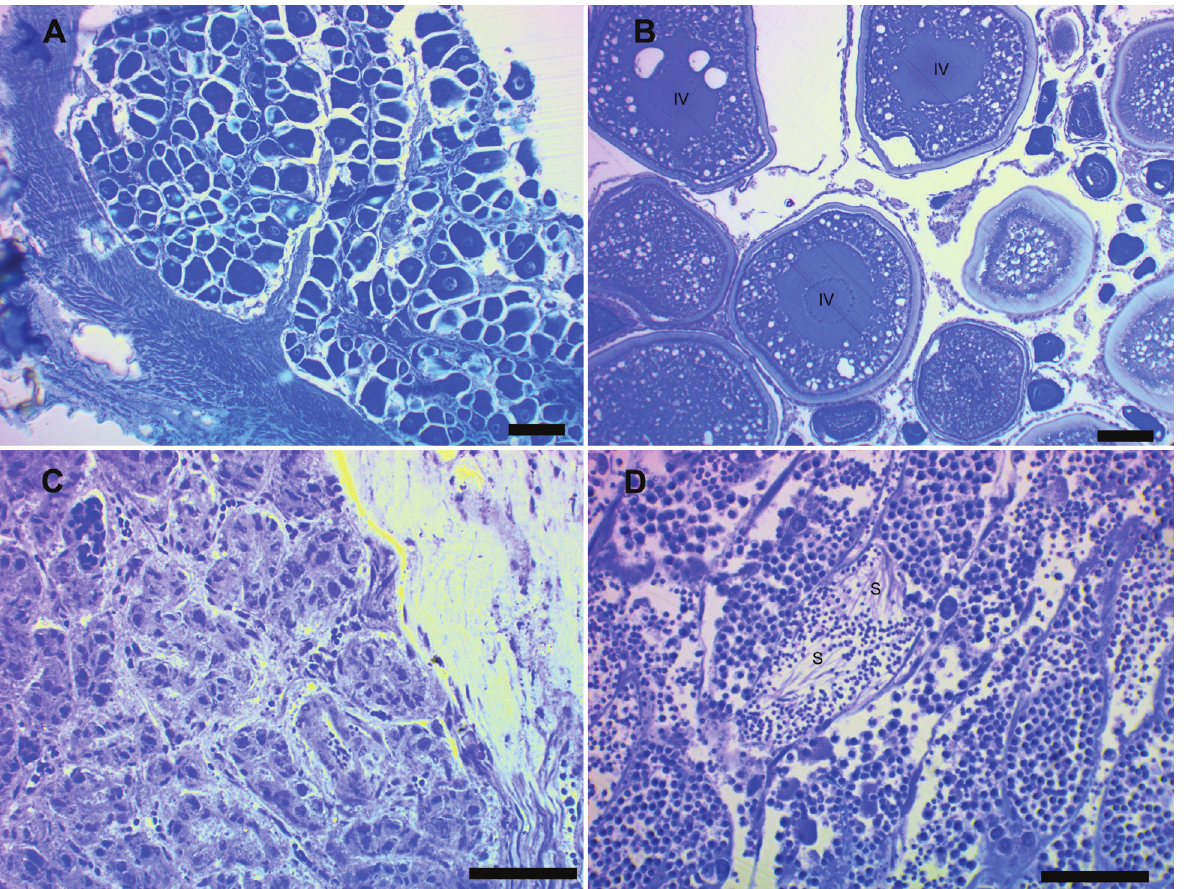
Figure 2. Histological sections of gonads of Lutjanus gibbus from Fiji. ( A ) Ovary of immature female (21.6 cm L primary-growth oocytes; ( B ) ovary of mature female (27.3 cm L (IV); ( C ) testis from an immature male (22.6 cm L